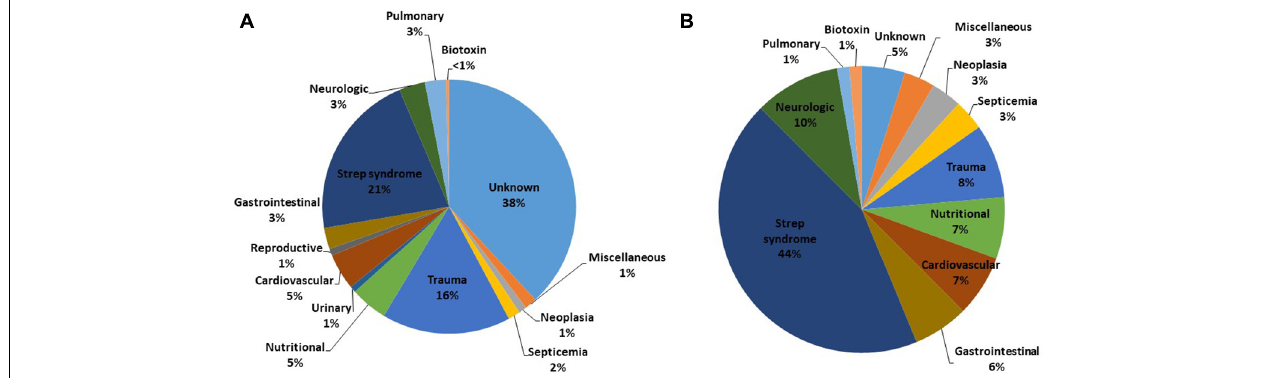
FIGURE 2 | Proximate causes of mortality for (A) all northern sea otters ( Enhydra lutris kenyoni ) recovered in Alaska from 2002 to 2012 ( n = 780) and (B) a subset of those recovered in good condition (freshly dead, and never frozen) with complete histopathology and ancillary diagnostics ( n = 144). Total percentages do not add to 100% due to rounding. Causes of death classified as “miscellaneous” included oiling, hepatobiliary, and fungal diseases.